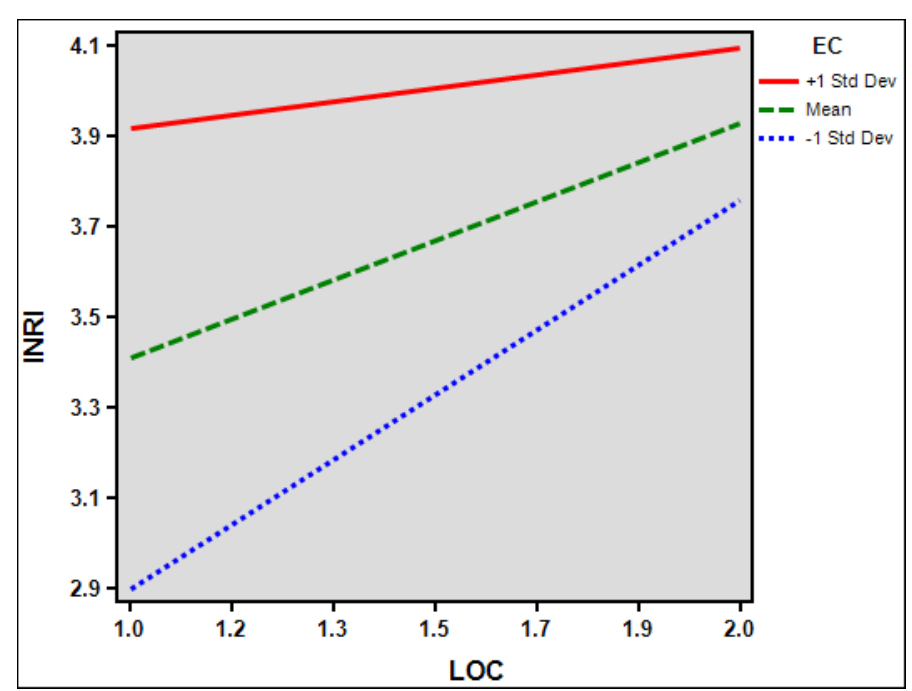
Figure 1. The plot of interaction effects of ethical culture on the relationship between locus of control and auditor reporting intention Source: Compiled by